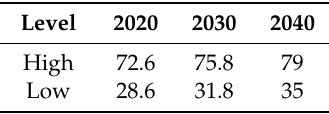
Table 3. System load of the NPS (GW) for the period